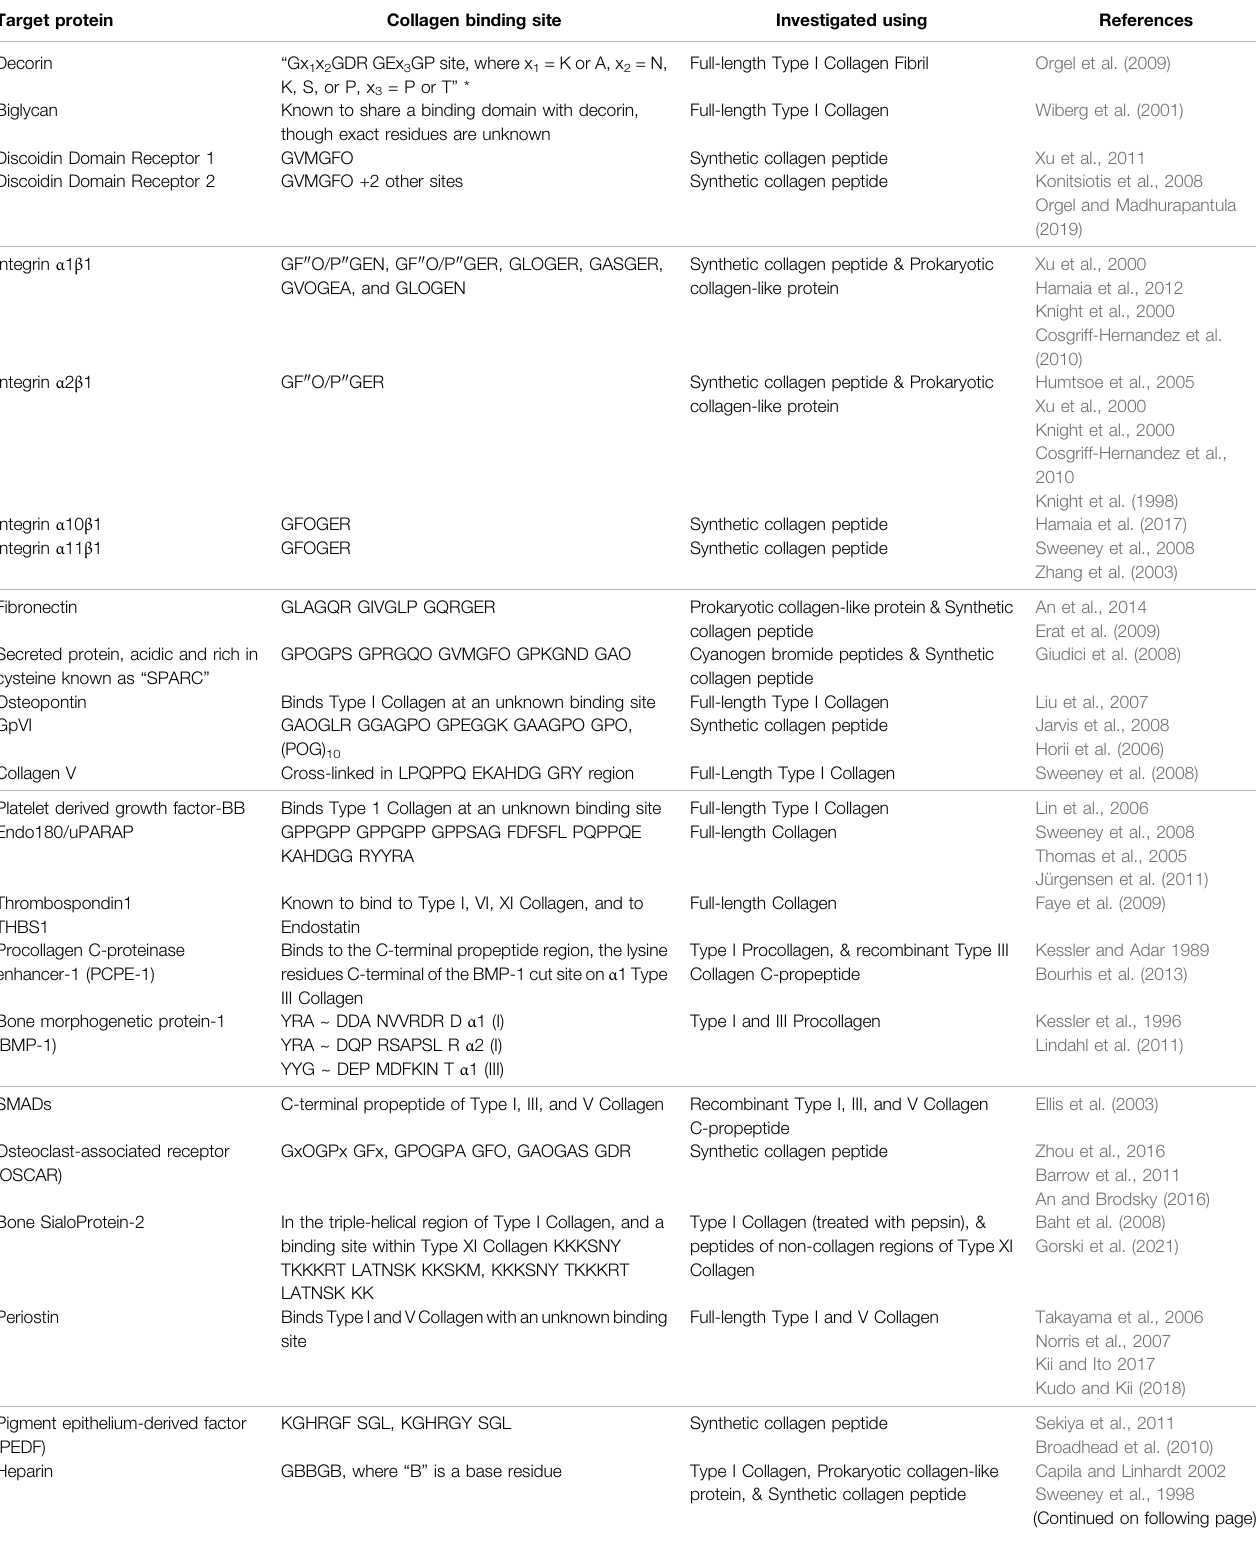
TABLE2| BindingsitesonhumancollagentovariousECMproteinsandcellularreceptors.SymbolDe fi nition:*-computationalmodelingusedtode fi neresidues,~denotes protease cut site in the protein sequence, † protease cut site was determined using Mass Spectroscopy, “ O/P ” means that both hydroxyproline and proline have been used and were shown to interact, “ x ” represents any amino acid unless otherwise